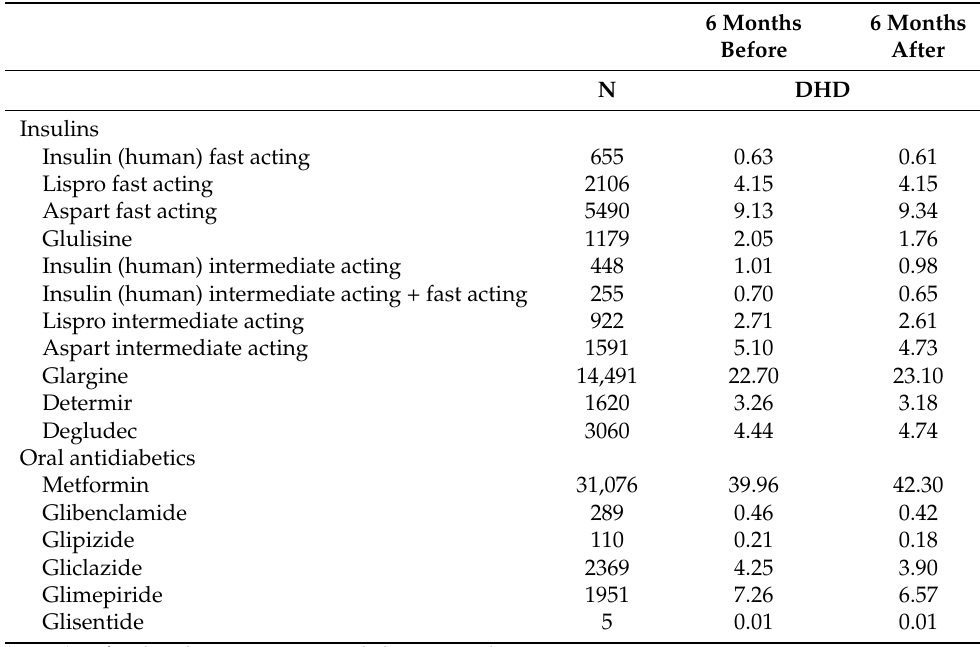
Table 4. Number of DHDs 6 months before and 6 months after